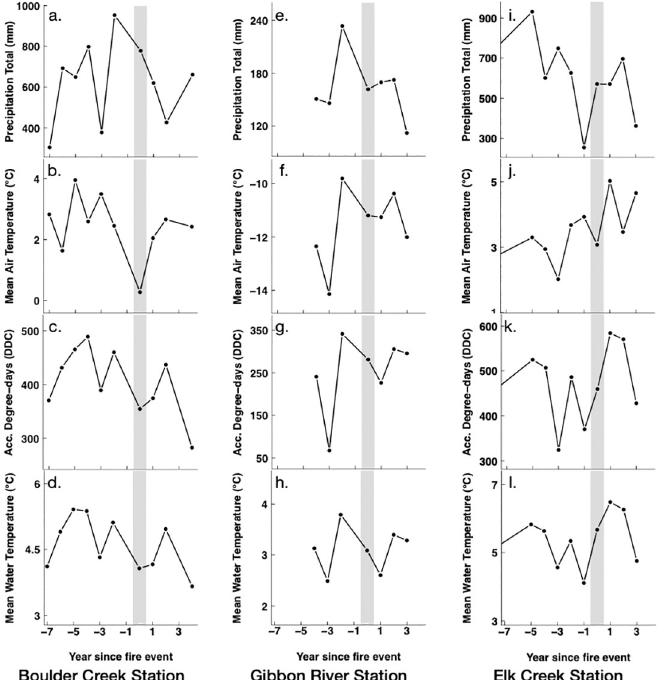
Fig 2. Times series of pre- and post-fire winter precipitation totals, mean air temperatures, accumulated degree days, and mean water temperatures at (a-d) Boulder Creek, (e-h) Gibbon River, and (i-l) Elk Creek sites. Grey line represents the fire